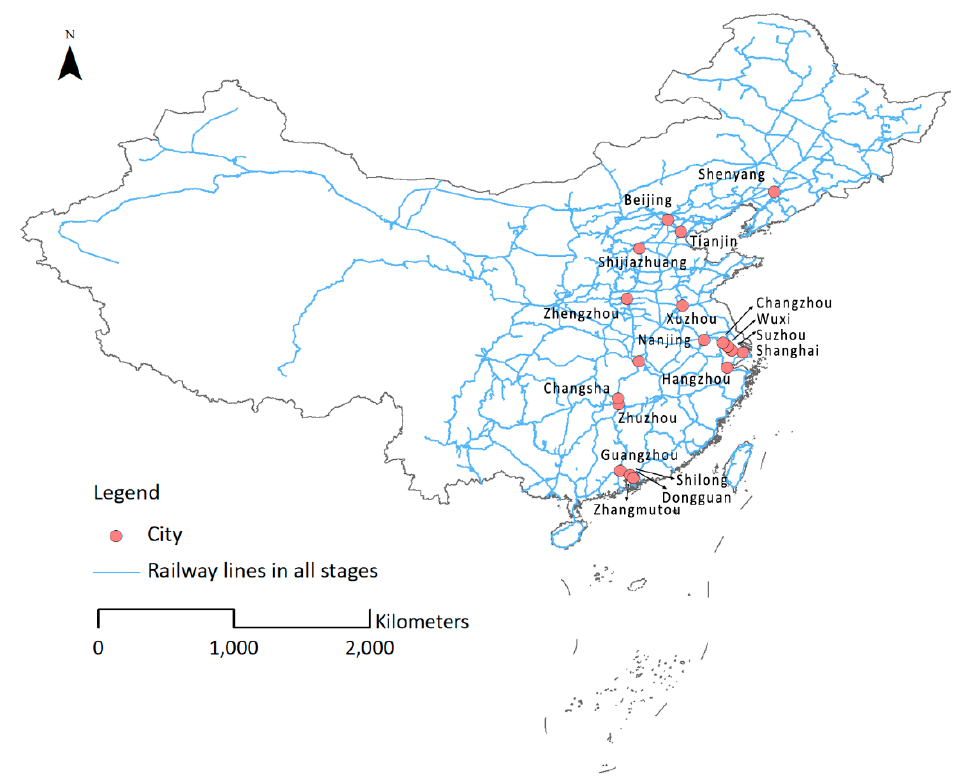
Figure 8. Spatial distribution of the weights of top 10 cities.